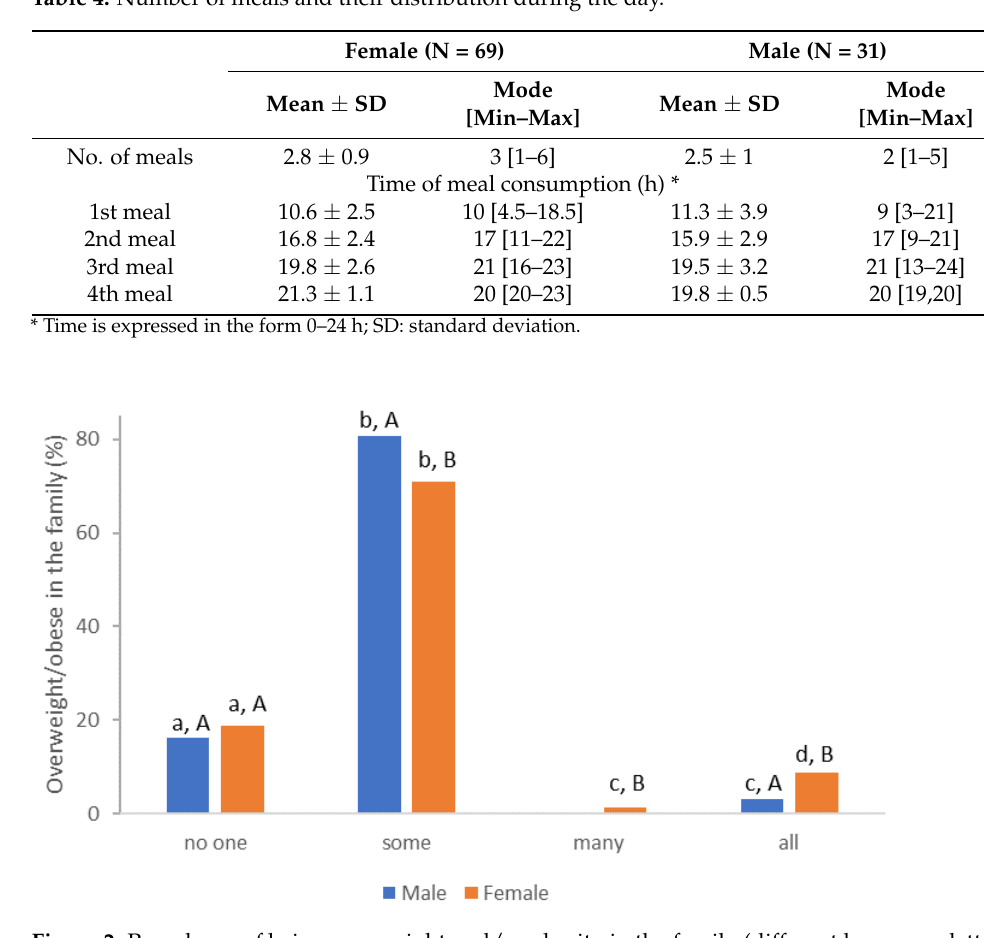
Figure 2. Prevalence of being overweight and/or obesity in the family (different lowercase letters: significant differences in the frequency of overweight or obese family members, within the same gender; different capital letters: significant difference in the frequency of overweight or obese family members within different gender). Table 3. Frequency of consumption of certain foods and drinks.